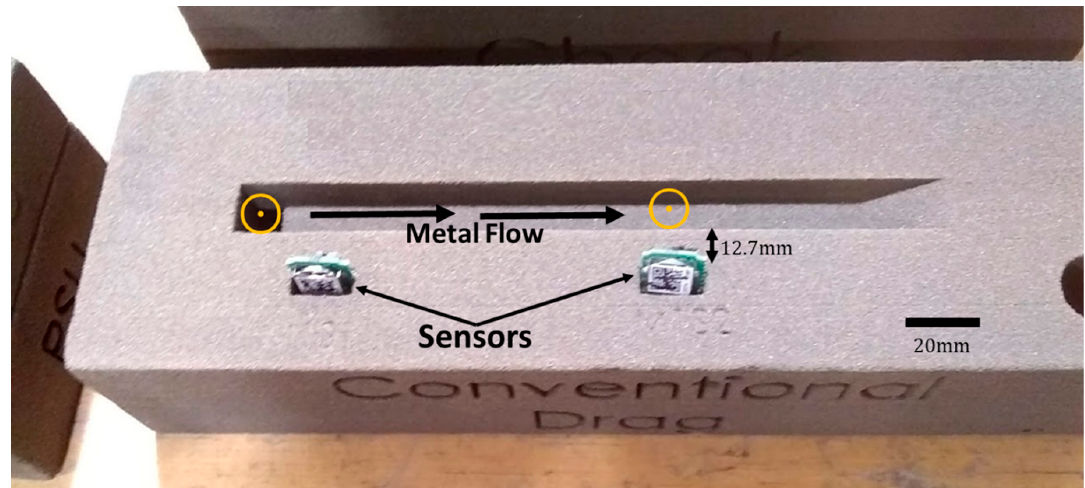
Figure 1. Melt flow velocity sensors embedded into a 3D-printed sand drag prior to assembly of the full mold.